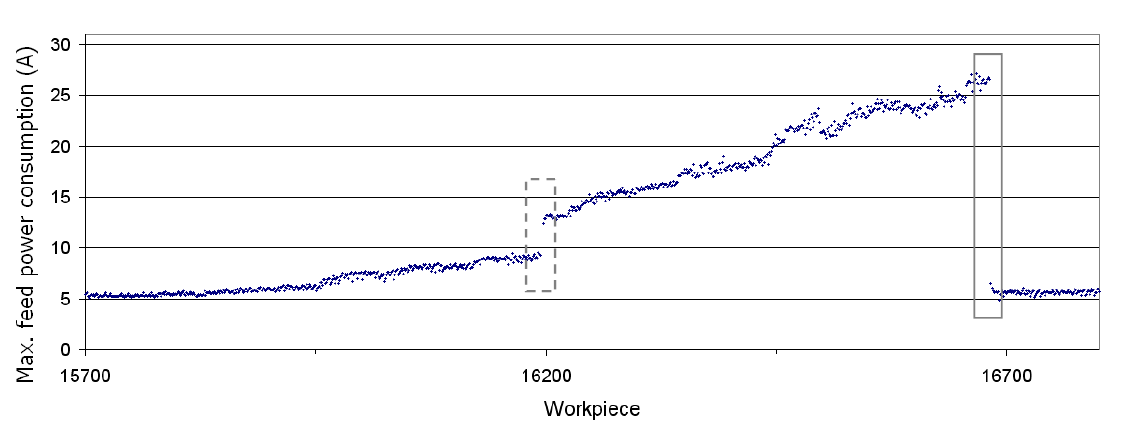
Figure 2. Evolution of maximum feed-power consumption in a group of roughing inserts over 1,000 machined workpieces.